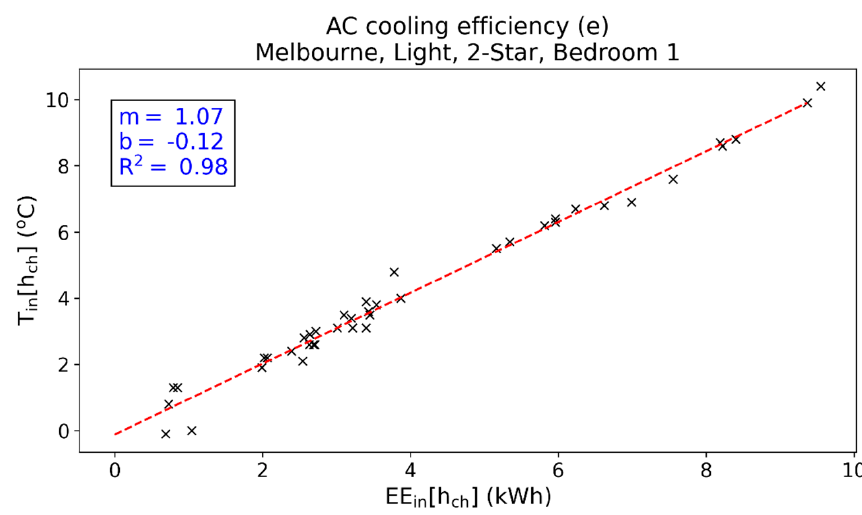
Figure 2. Scatter plot of EE in [ h ch ] versus T in [ h ch ], defining the AC cooling efficiency ( e ) for Bedroom 1 in template home M2L.